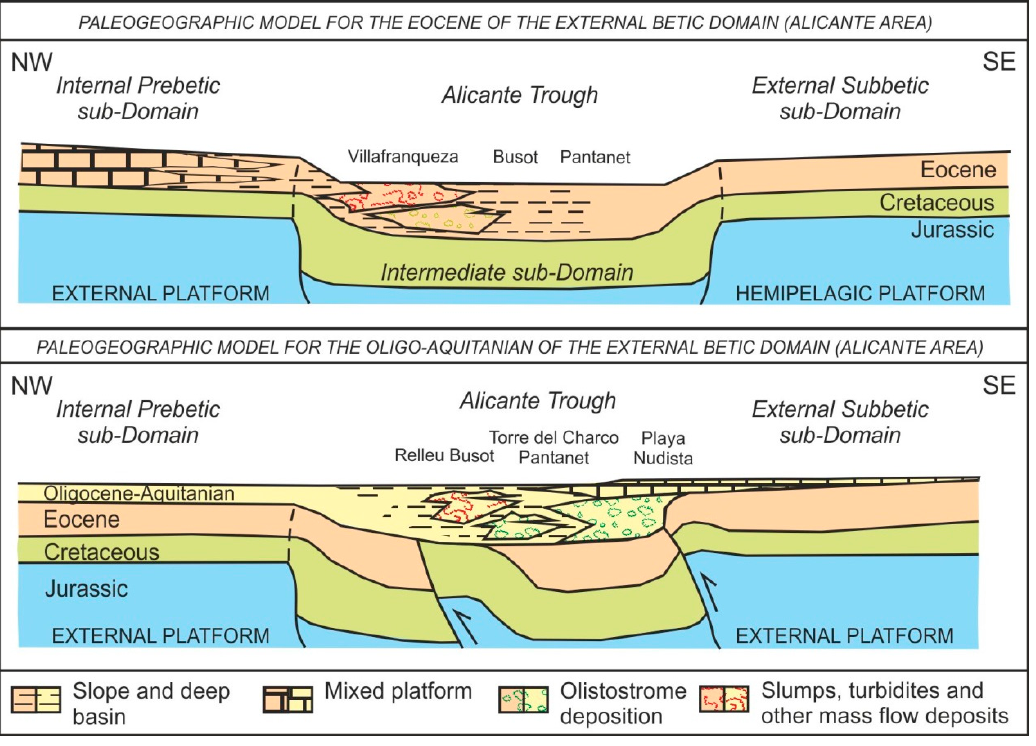
Figure 10. Eocene and Oligo-Aquitanian tectono-sedimentary evolution of the Cenozoic Alicante Trough and neighbor areas (Alicante province) of the eastern EBZ (after Reference [18]; modified). Paleogeographic sketch showing a cross-section referable to the Oligo-Aquitanian interval, in the lower part , and to the Eocene, in the upper part .